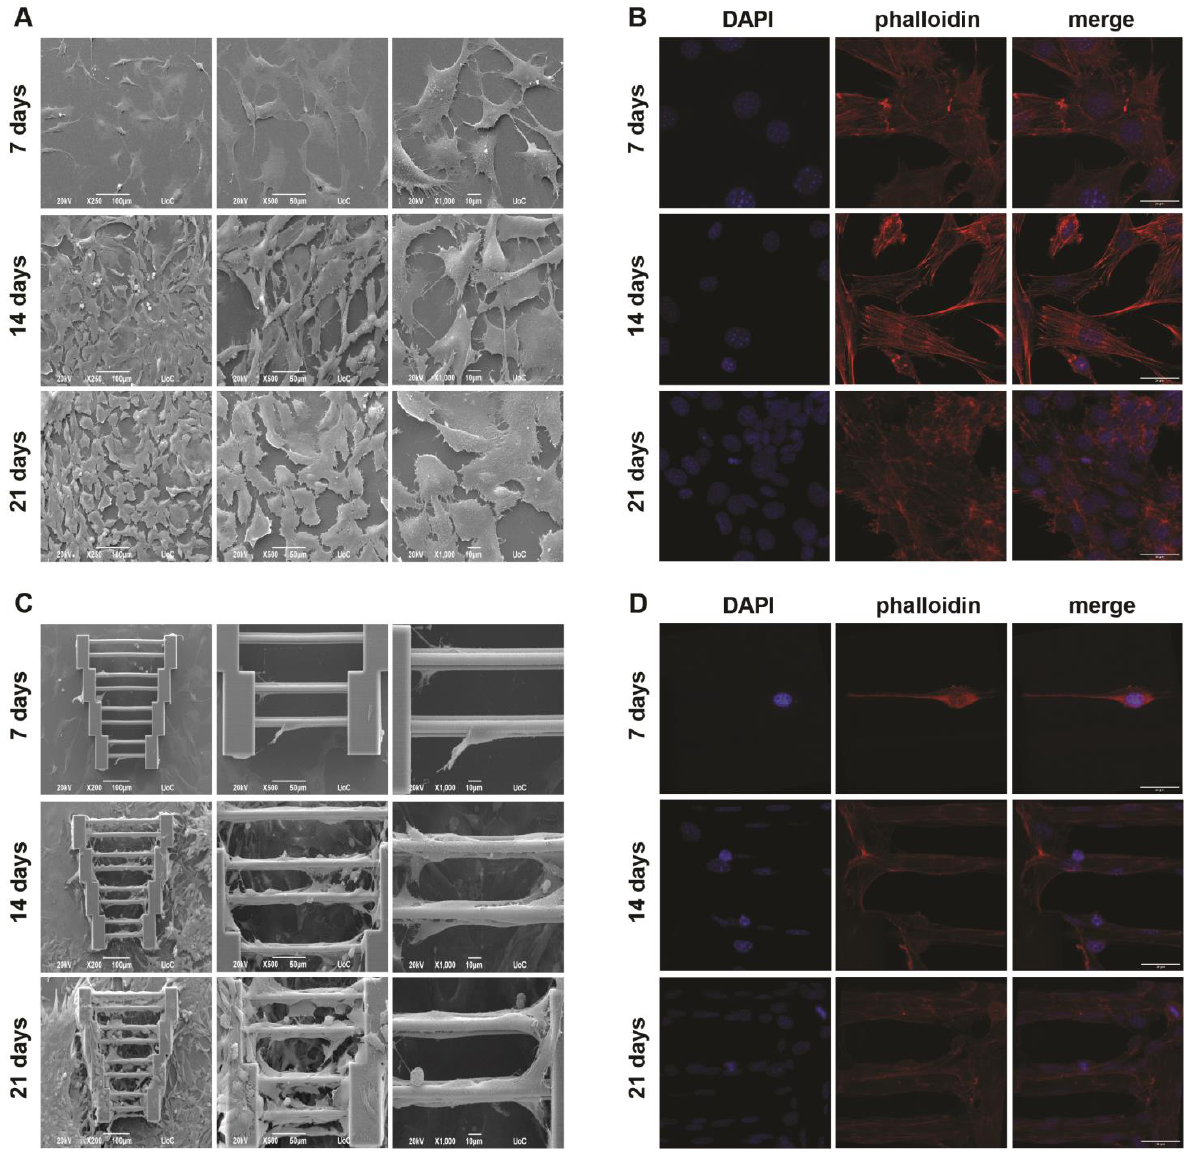
Figure 2. SW10 mono-cultures. ( A , B ) Cultures on flat glass coverslips. SEM ( A ) and confocal ( B ) images show that the cells have a random orientation. ( C , D ) Cultures on scaffolds. SEM ( C ) and confocal ( D ) images show a selective orientation along the guidewires, at all timepoints. Scaffold saturation does not seem to be a limiting factor for cell directionality. Scale bars in panels ( B ) and ( D ) are given in the merged images and are 30 μm.